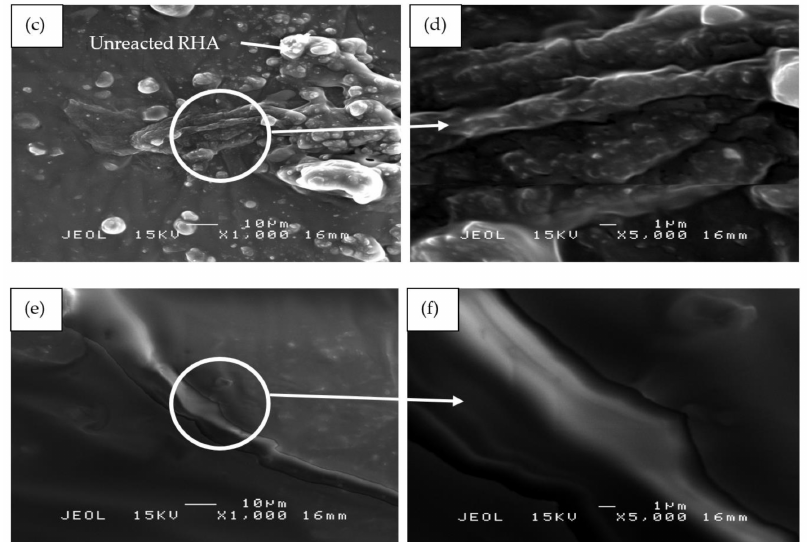
Figure 13. SEM micrographs of RHA/SiR-based binary blended geopolymer coating composite before the moisture absorption test with ( a , b ) good (sample S1), ( c , d ) moderate (sample S14), and ( e , f ) poor moisture absorption properties (sample S21) at 1000 × and 5000 ×